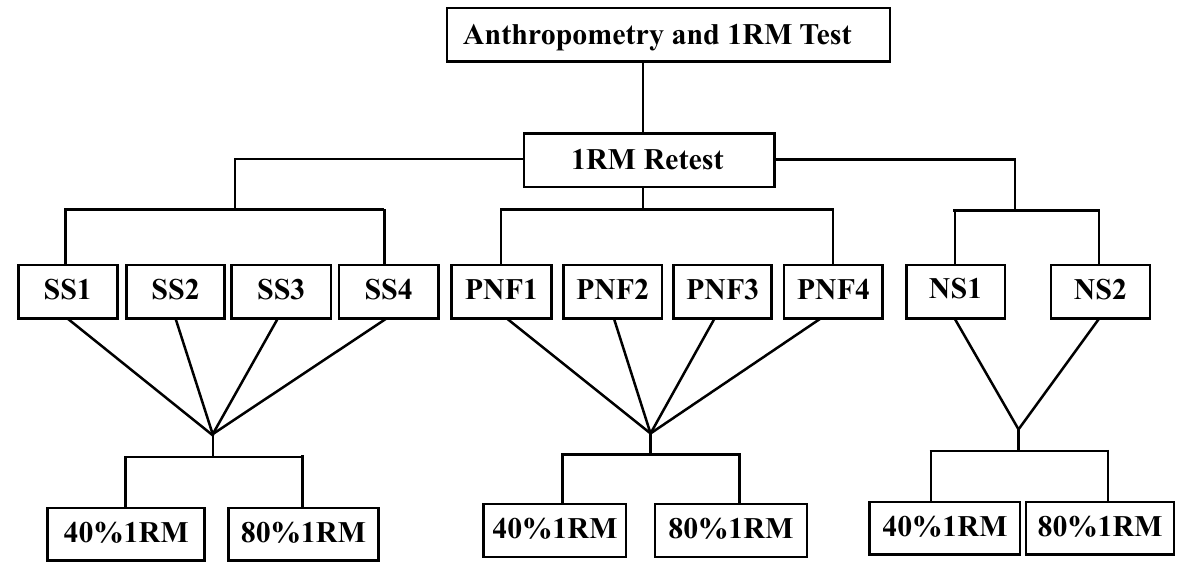
Figure 1. Experimental design